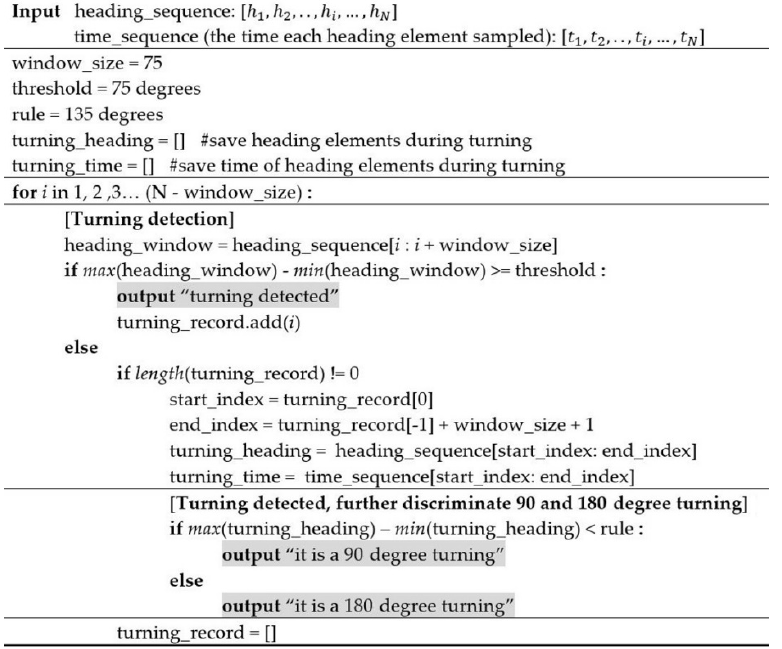
Figure 12. The pseudo code of turning detection discriminates 90-degree from 180-degree